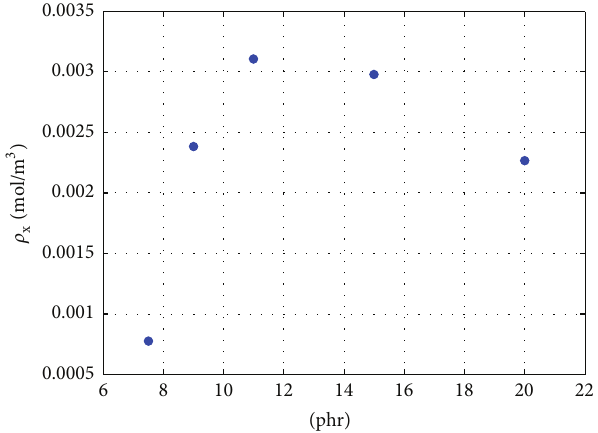
Figure 6: Cross-link density of epoxy as a function of hardener percentage [23].